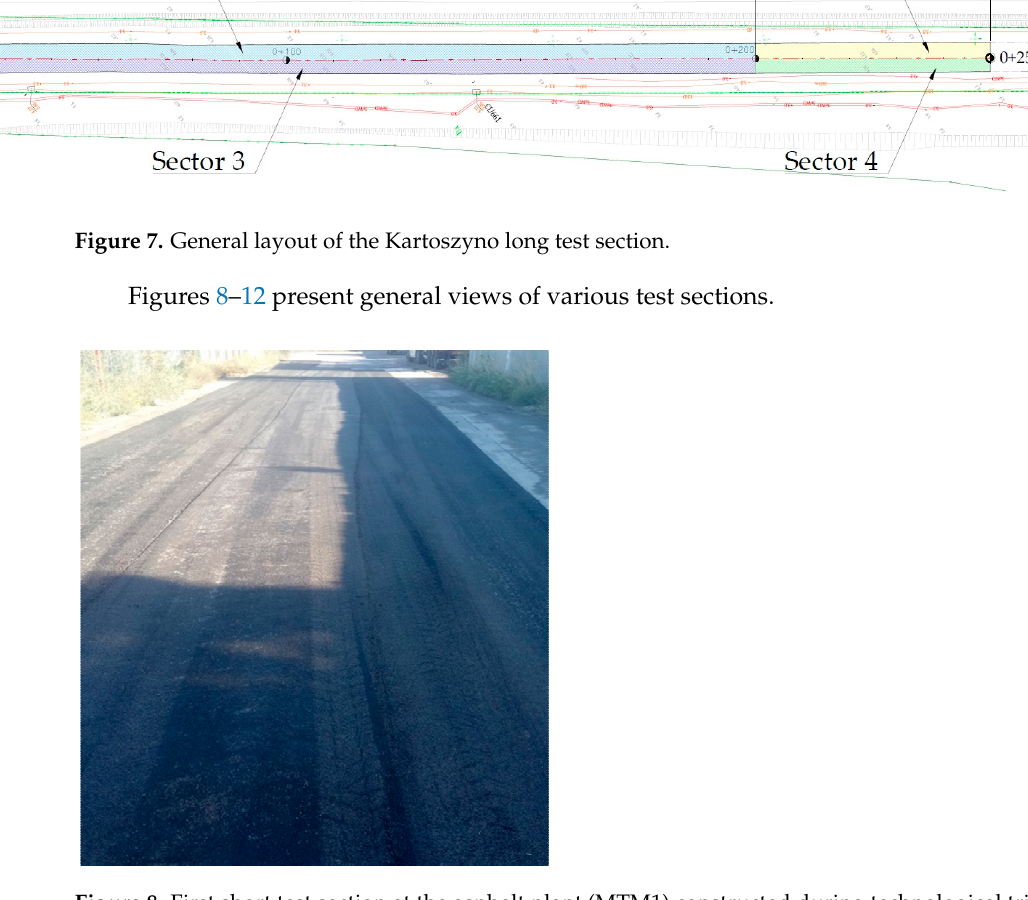
Figure 9. First long test section (D)–D ą brówka, June 2019. Figure 10. Second long test section (G)–Galaktyczna St., Gda ń sk, September 2019.